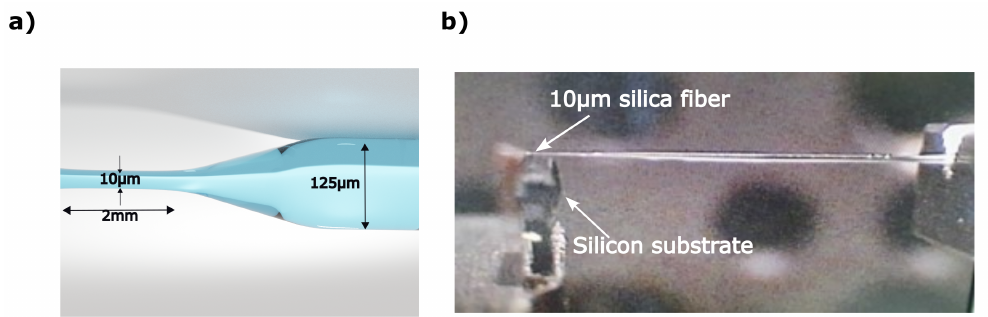
Figure 2. Optical fiber tapering for the experiment: ( a ) Rendered fiber architecture with obtained dimensions. ( b ) Photograph of the tapered fiber of adiabatic tapering, captured during gluing of the fiber onto the silicon